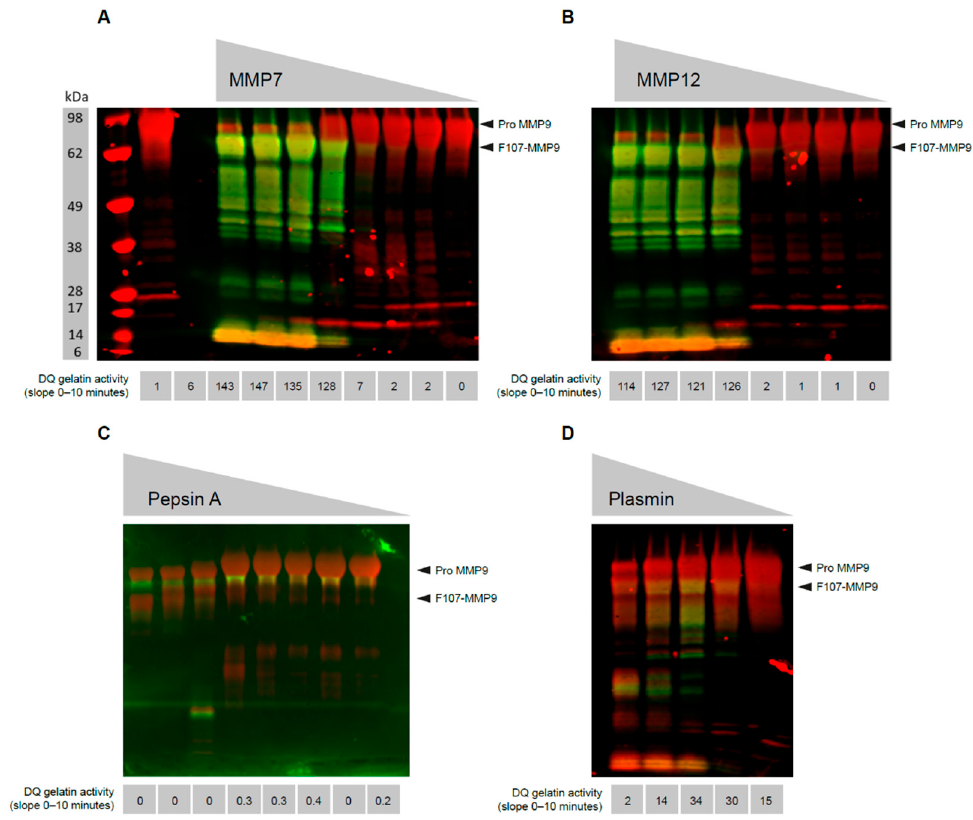
Figure 1. Activation of MMP9 by distinct proteases in vitro. Western blots for pro-MMP9 (92 kDa, red) and active MMP9 (84 kDa, green) after incubation with active ( A ) MMP7, ( B ) MMP12, ( C ) pepsin A, and ( D ) plasmin. Below each lane is the MMP9 activity towards gelatin expressed as gelatin fluorescence (arbitrary units) per minute. DQ, dye-quenched; MMP, matrix metalloproteinase.